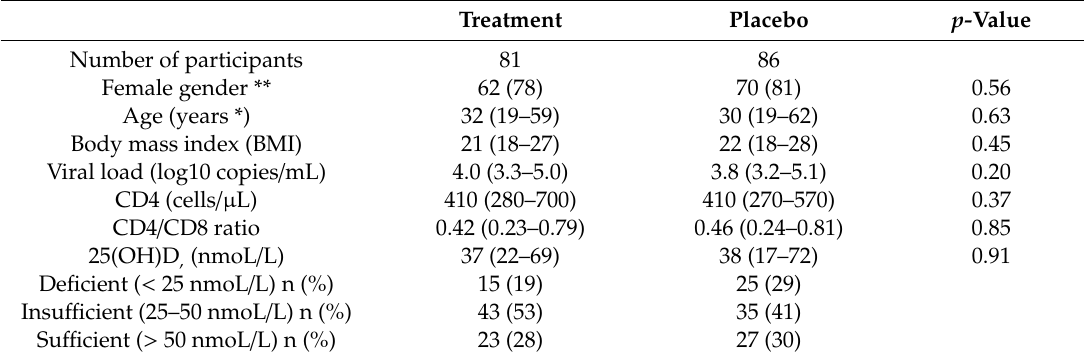
Table 1. Baseline characteristics of study